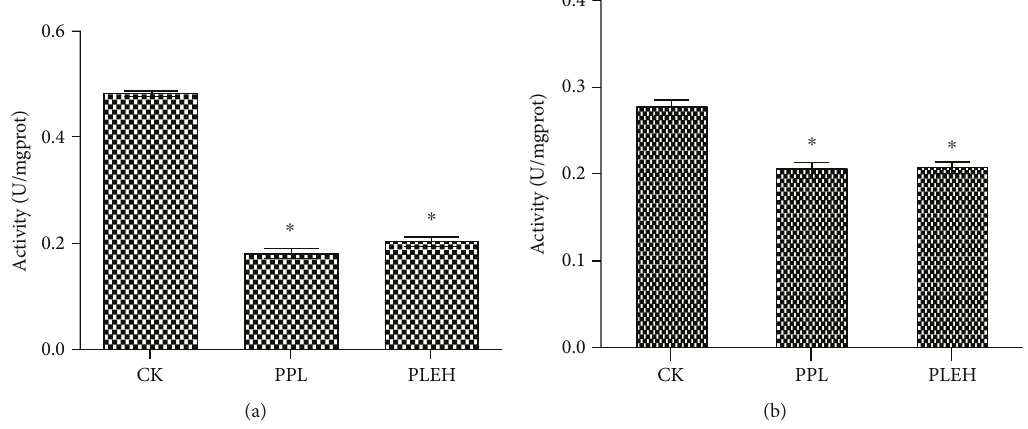
Figure 9: Comparison of acetylcholinesterase (AChE) activities for hippocampi (a) or palliums (b) from suckling o ff spring among the CK, PPL, and PLEH groups. Signi fi cant di ff erences were indicated by the symbol “ ∗ ” for each group ( P < 0 05